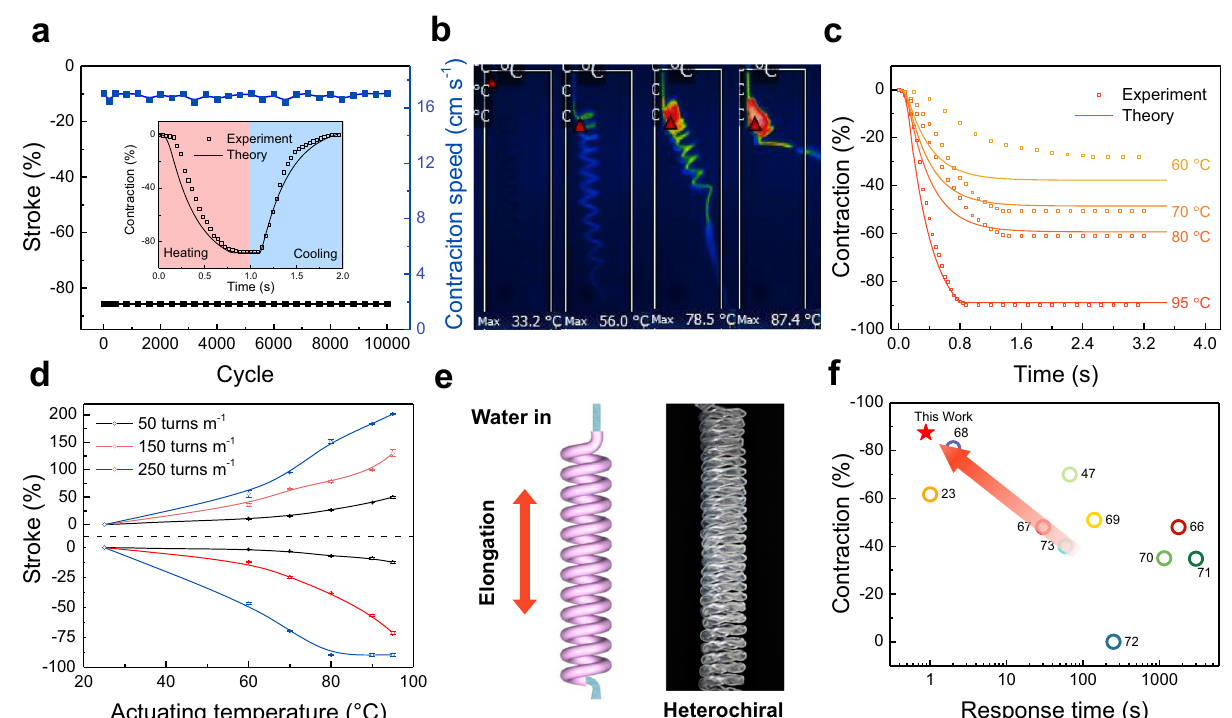
Fig. 3 Actuation performance of load-free tensile hollow- fi bre actuators. a Tensile stroke and contraction speed during 10,000 fl uid-driven heating- cooling actuation cycles. Inset: time dependence of contraction driven by alternatively fl owing 90 °C and 25 °C water at a fl ow rate of 1.72 g s − 1 . b Infrared images of the homochiral PEHF 580-990 actuators during water fl ow. c Experimental and theoretical results of a homochiral PEHF 580-990 actuator driven by fl owing water at different temperatures. d Actuation stroke as a function of water temperature for heterochiral and homochiral PEHF different inserted twist densities. e Schematic illustration and photograph of the heterochiral PEHF 580-990 actuator. f Comparison of the contraction